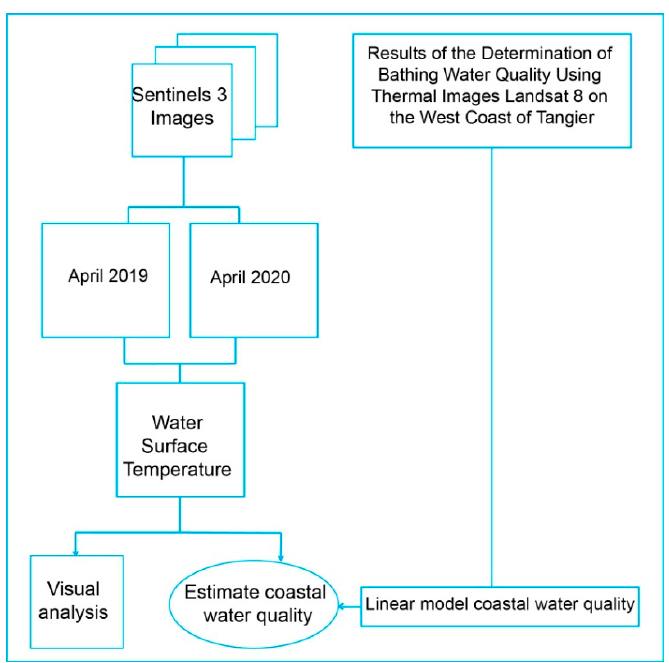
Figure 3. Flowchart of the Tangier western coastal water quality investigation using Sentinel 3 water surface temperature (WST) data.